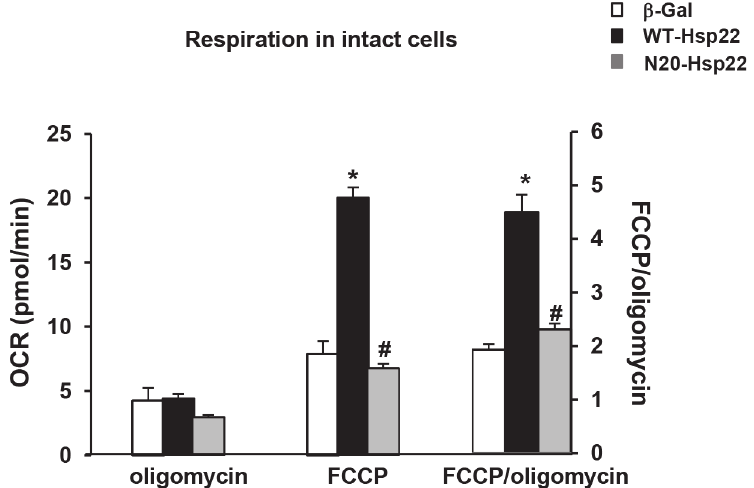
Fig 5. Effect of N-terminus mutant Hsp22 on mitochondrial respiration in intact neonatal rat cardiac myocytes. Mitochondrial respiration measured by Clark electrode in intact myocytes transfected with Ad- WT-Hsp22 or Ad-N20-Hsp22 compared to β -Gal. Mitochondrial respiration is presented on the left Y axis as OCR after addition of oligomycin and OCR after addition of FCCP, and, on the right Y axis, as the ratio of both rates (FCCP/oligomycin). * , P < 0.05 versus β -Gal; #, P < 0.05 vs Ad-WT-Hsp22. n = 5 per